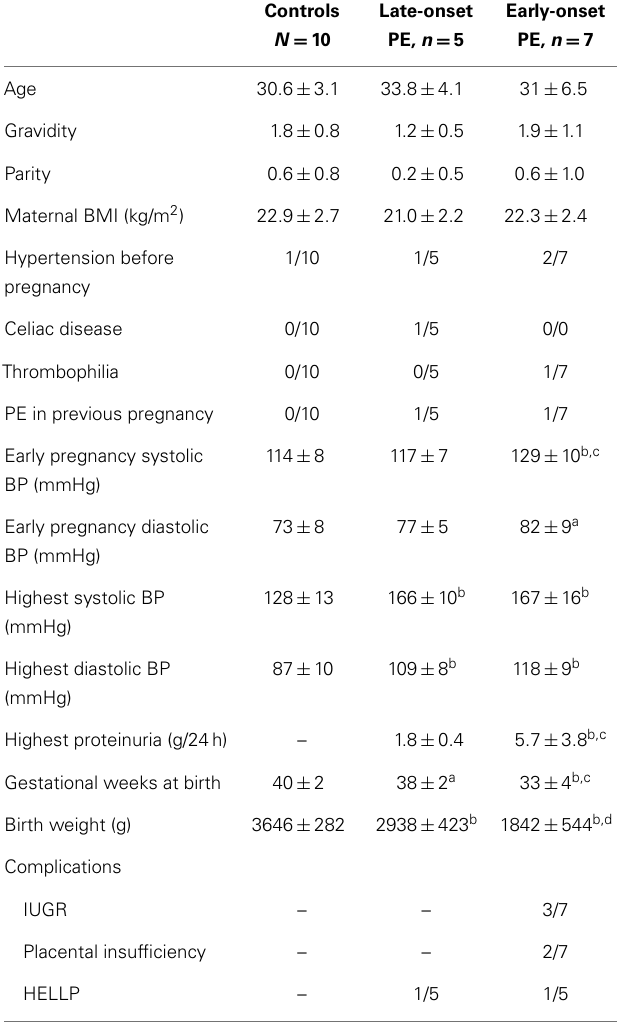
Table 1 | Clinical characteristics of the study population